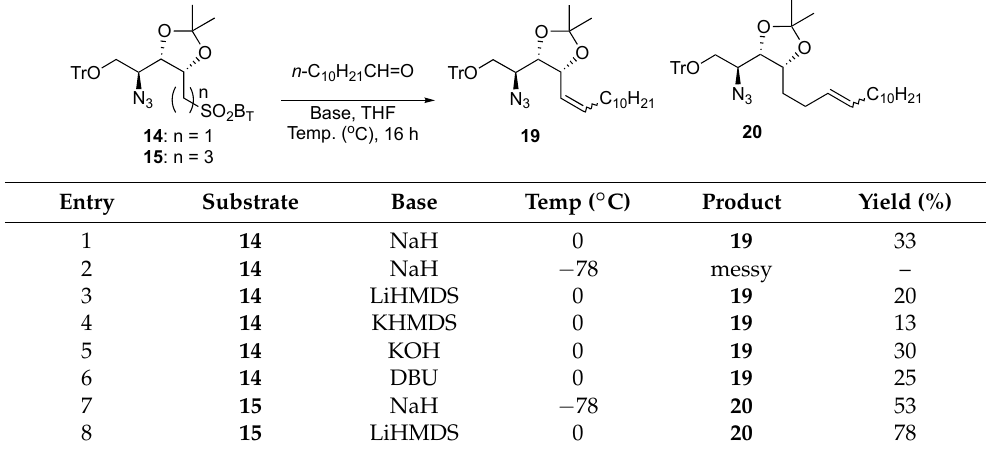
Table 1. Julia-Kocienski olefination reaction of sulfones ( 14 and 15 ) with undecanal.